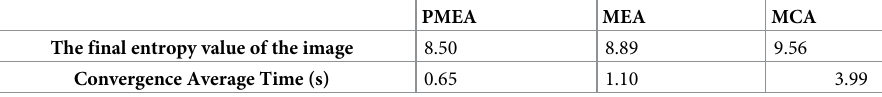
Table 2. Comparison of simulation